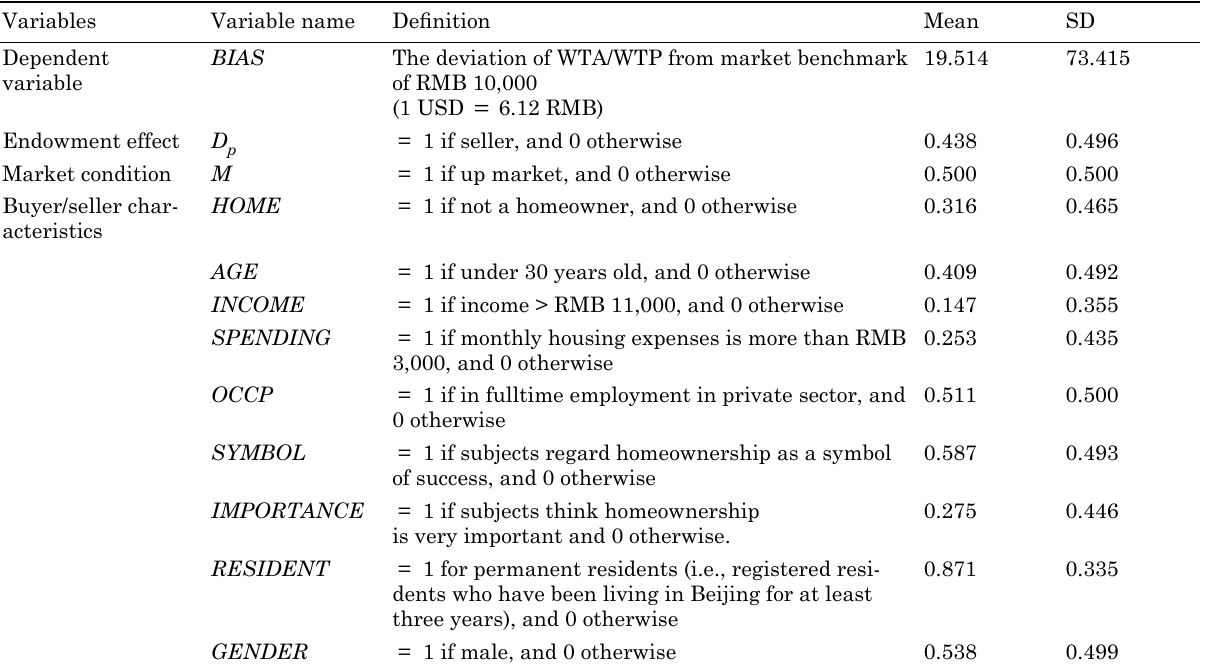
Table 3. Variable definition and descriptive